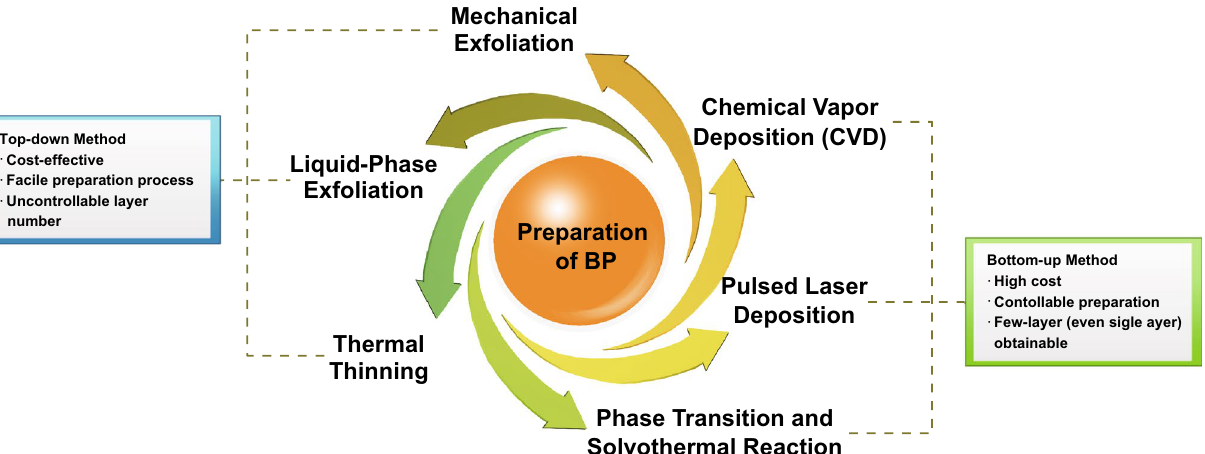
Fig. 2 Overview of currently available preparation strategies and characteristics for fabricating 2D BP